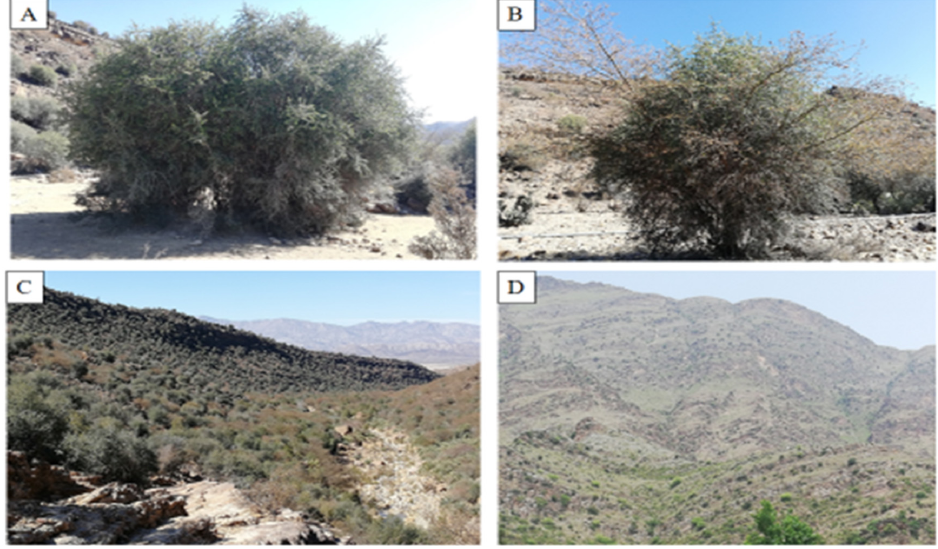
Figure 5. ( A ) Monotheca - Olea phytocoenosis; ( B ) Monotheca - Acacia phytocoenosis; ( C ) Monotheca - Olea - Acacia mixed forest; ( D ) very scarce vegetation of Monotheca . Similarly, the ecosystems dominated by Monotheca and Eucalyptus formed the third Table 2. Phytocoenotical differentiation of M. buxifolia associations based on densitometric and vegetation type in the studied area and were located at a lesser altitude (1031 m asl) and topographic moderate slope. Tree density for this group was 296.2 ha − 1 ; however, due to the presence of large diameter trees, the basal area (95.93 m 2 ha − 1 ) was the maximum among all the reported vegetation types. The density of the Monotheca pure crop was 320 trees ha − 1 with a basal area of 89.39 m 2 ha − 1 and signs of human interventions were reported. In these forests, the predominance of some plant species was due to environmental, topoclimatic, edaphic, and relief condition. Reported native (82%) and exotic (8%) tree species were mostly dicot (73%) with predominately megaphanerophytic lifeforms (88%), microphyll (33%), which largely reflect strong chronological differentiation, and distinct linkage (55%) to the Sino-Japanese phytogeographical region (Table 3). Table 3. Summary of chorologies, tree type, life form, and leaf spectra of the documented tree species. Chorologies